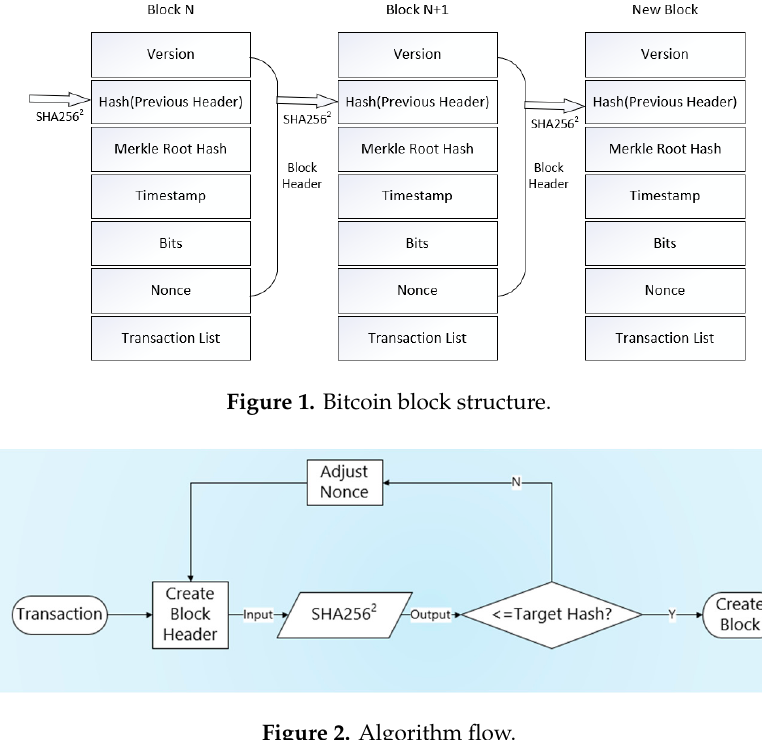
Figure 2. Algorithm flow. Figure 2. Algorithm